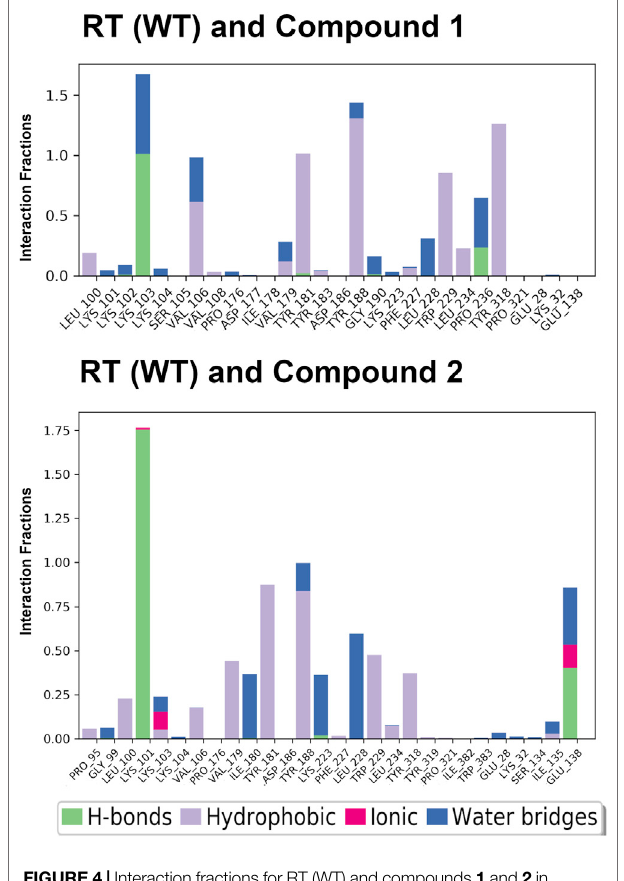
FIGURE 4 | Interaction fractions for RT (WT) and compounds 1 and 2 in the 24 ns simulations. Protein interactions with compounds 1 and 2 were monitored throughout the simulation and are characterized by hydrogen bonds (H-bonds; green); hydrophobic contacts (purple); ionic bonds (pink), and water bridges (blue). Simulation interactions diagrams provided in Supplementary Material ( Supplementary Figures S3, S6 ) show % interactions between speci fi c residues and functional groups of the compounds. The interaction fraction describes how long interactions are maintained over the course of the trajectory snapshots. An interaction fraction of1.0suggeststhatthisinteractionismaintainedinthesimulation100%ofthe time.Interactionsfractions > 1.0representresiduescapableofmakingmultiple contacts with the compound.